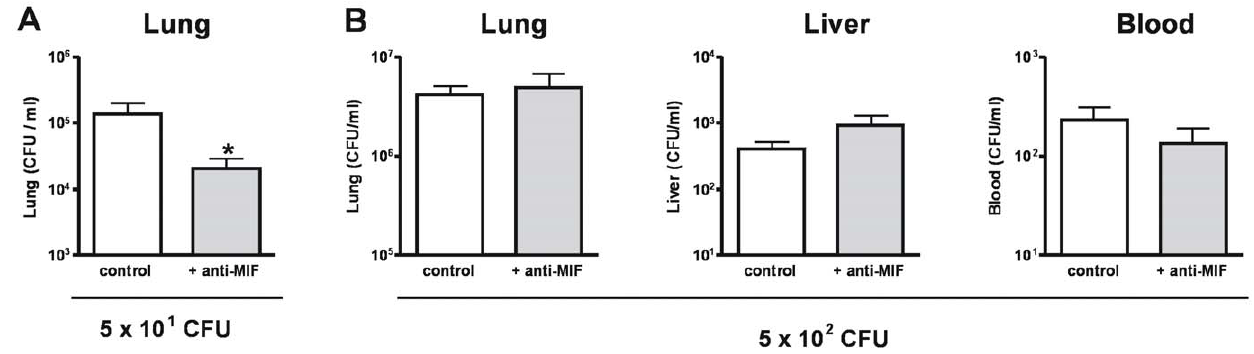
Figure 6. Effect of anti-MIF treatment on bacterial clearance is dependent on the inoculum size. Mice were treated with non-immune IgG control (white bars) or anti-MIF antibodies (grey bars) and inoculated with 5 6 10 1 CFU ( A ) or 5 6 10 2 CFU ( B ) B. pseudomallei intranasally after which bacterial outgrowth in the lungs, liver and blood was analysed 48 hours later. No bacterial outgrowth in the liver and no bacteremia was observed in any of the mice inoculated with 5 6 10 1 CFU B. pseudomallei . Data represent mean 6 SEM of n=8 mice per group; * p , 0.05.